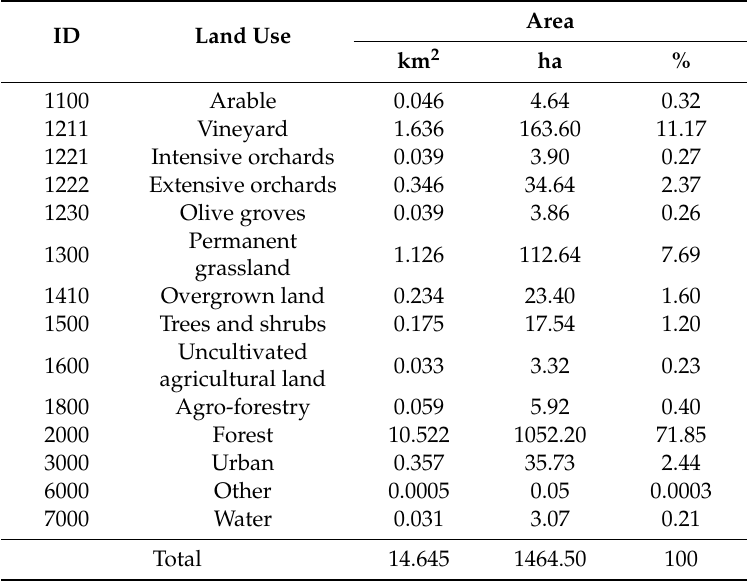
Table 1. Spatial analysis of land use in the Kožbanjšˇcak stream